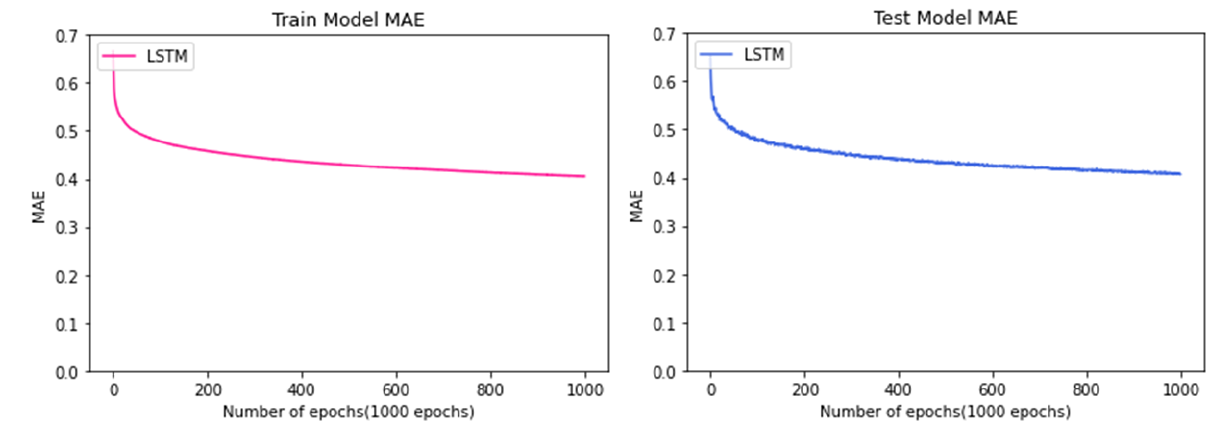
Figure 12. Comparison between train data and test data of the model using the LSTM